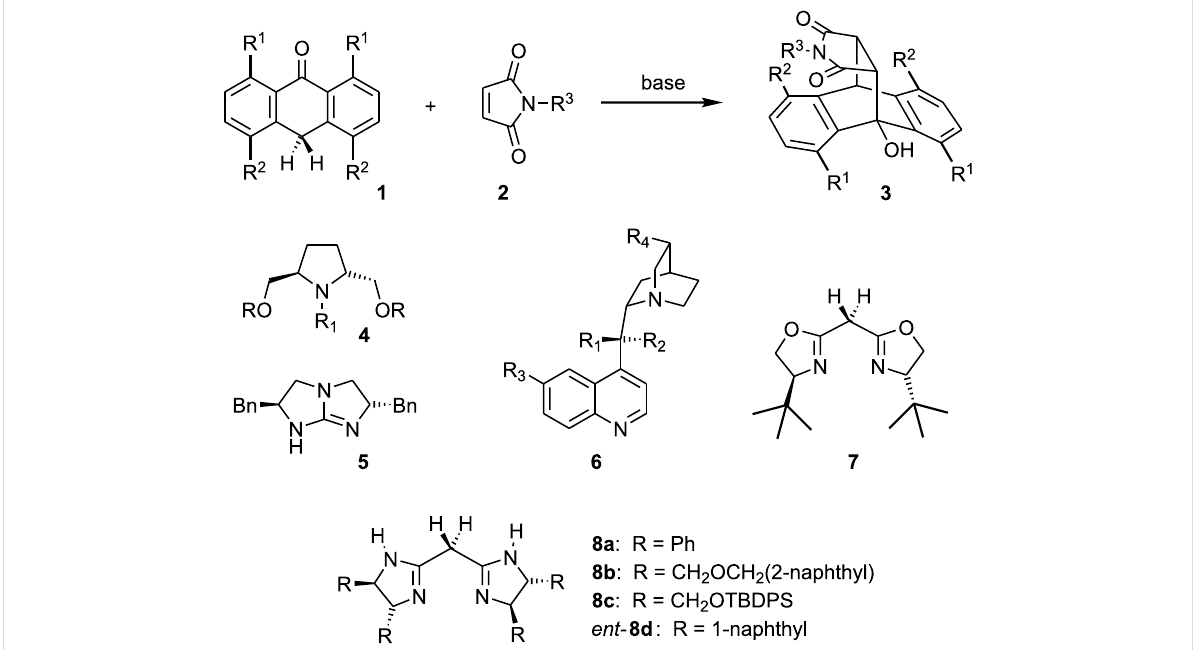
Scheme 1: Diels-Alder reaction of anthrones 1 and maleimides 2 catalyzed by chiral Brønsted bases 4 – 8 .